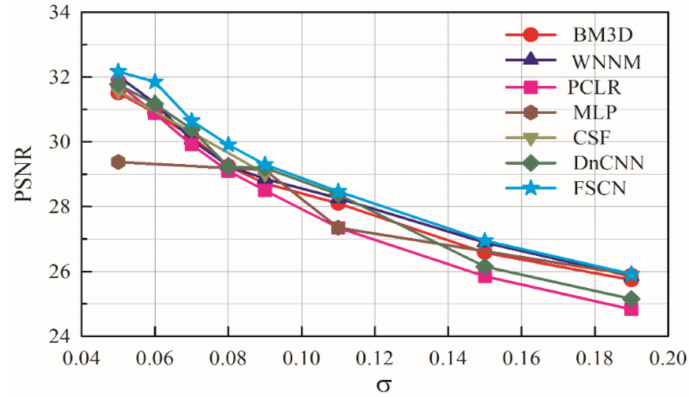
Figure 9. Average PSNR results on 10 images for various noise